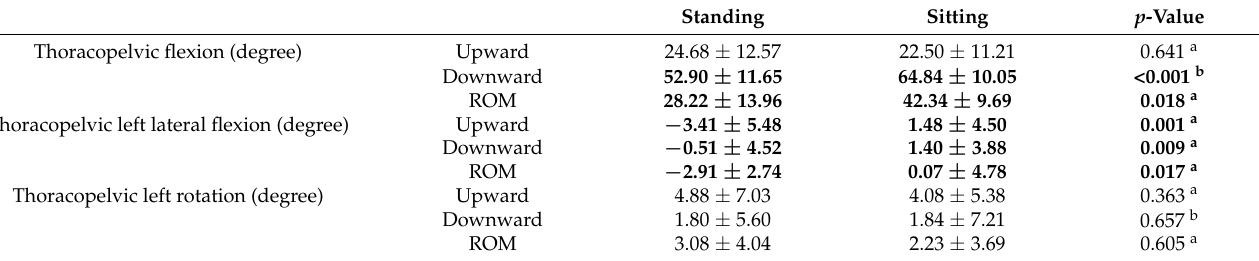
The values are presented as mean ± standard deviation. Upward: the time point when the sensor attached to forearm located at the most upward; Downward: the time point when the sensor attached to forearm located at the most downward; ROM: the difference between the value at Upward and that at Downward